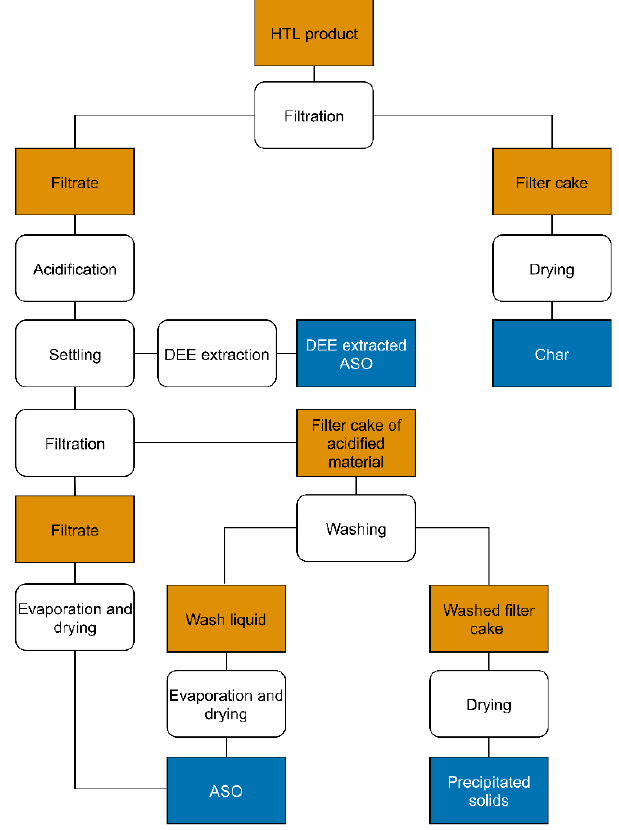
Figure 1. Schematic diagram of the fractionation of the reactor product. Energies 2021 , 14 , x FOR PEER REVIEW